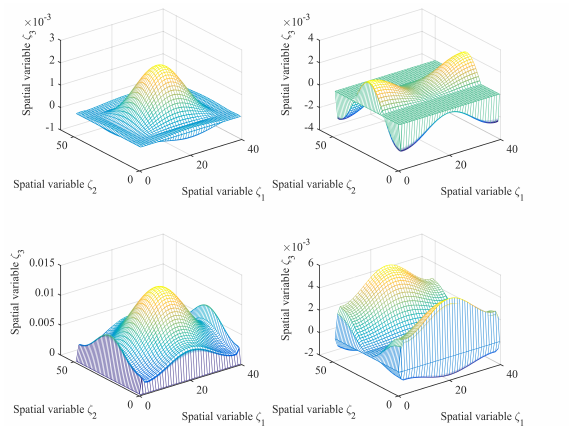
Figure 4. Evolution of the filtering error system for the first filter.